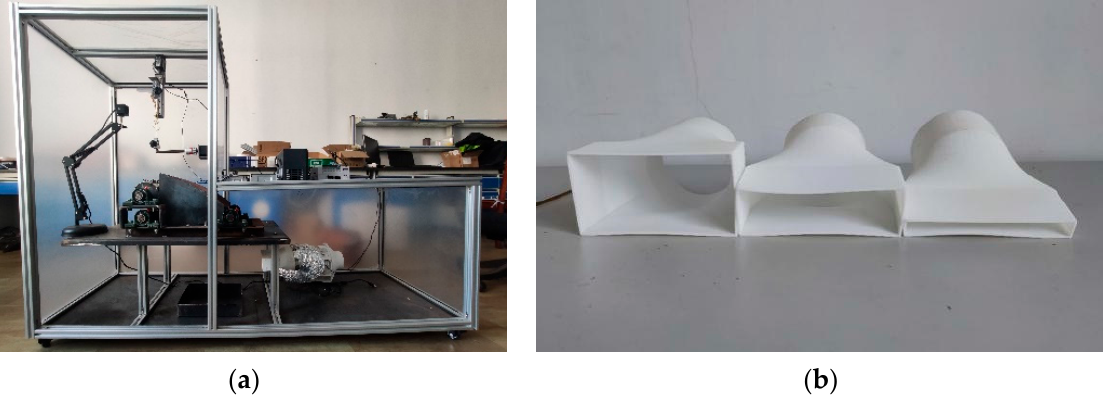
Figure 7. Diagram of experimental installation: ( a ) threshing screening system; ( b ) three different air vents.